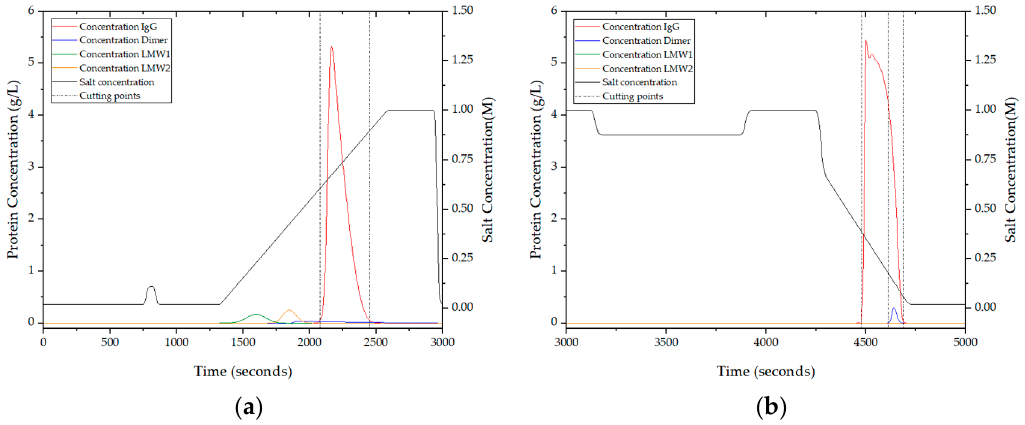
Figure 14. Simulation results of iCCC. ( a ) is IEX after five cycles, ( b ) is HIC after five cycles.